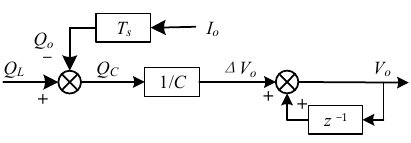
Figure 4. The CQM block diagram of a DCM inverter.